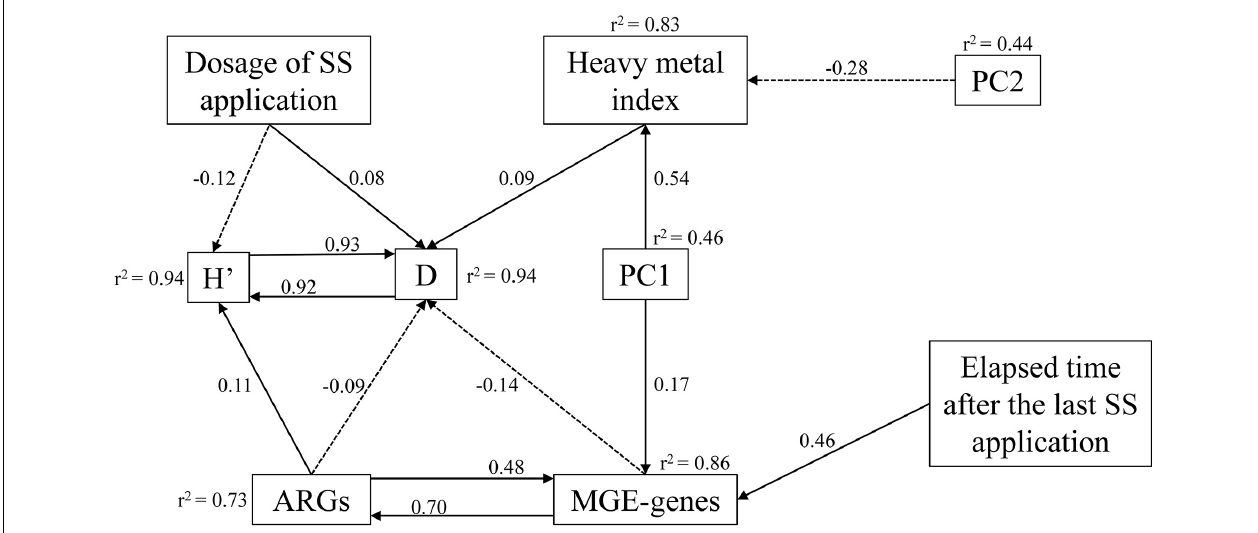
FIGURE 8 | Structural equation models showing direct and indirect effects of prokaryotic diversity indices, dosage of SS application, elapsed time after the last application, HM pollution index, PC1 and PC2 on ARGs and MGE-genes. Arrows indicate positive and negative relationships by solid and dashed lines, respectively. Numbers next to arrows represent standardized estimated regression weights ( p < 0.05). The r 2 -values indicate the proportion of variance explained for each variable. χ 2 = 31.5, AIC = 133, P = 0.416, df =